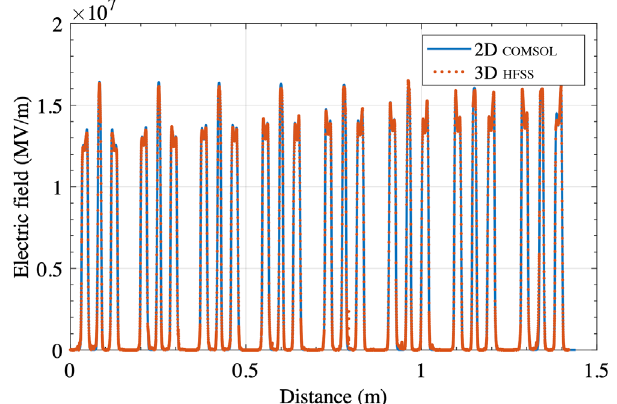
FIG. 14. Comparison of the axial electric field profile of the QA-DTL at 4 MV = m obtained in 2D COMSOL and 3D HFSS simulations.